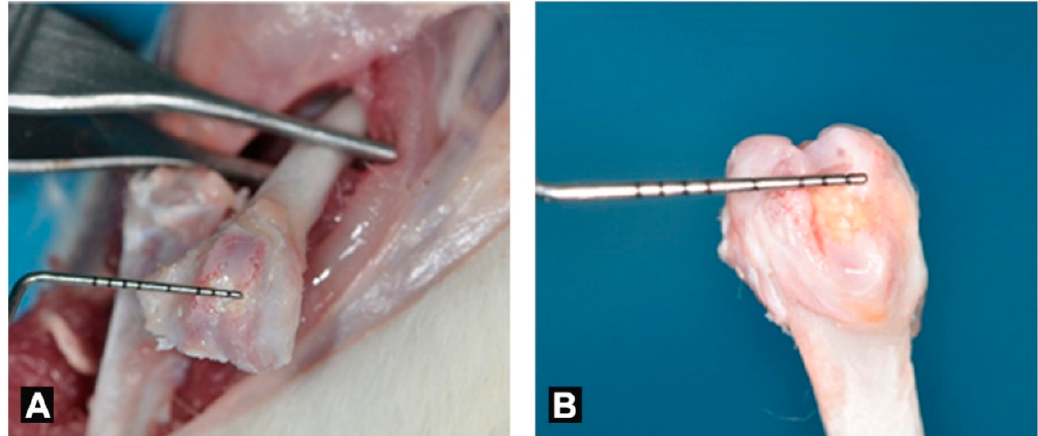
Figure 2. Representative images showing retrieval of the femoral condylar samples without any associated overlying soft tissue. ( A ) Sectioning the condylar bone from the remaining femur; ( B ) experimental bone defect with any remaining biomaterials if grafted.